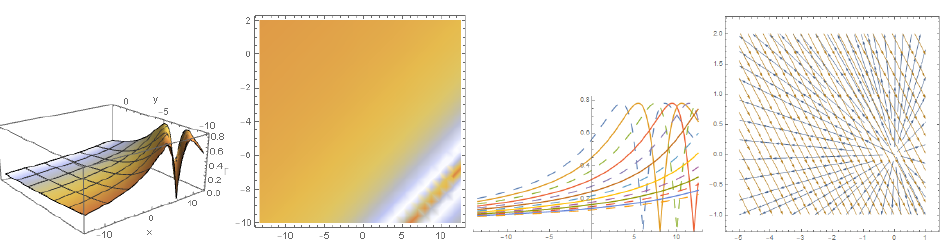
Figure 1. Evolution plots for Γ 1 ( x , y , t ) with the values η = − 1, c = 2, ρ = 2, λ = 2, m 4 = 9, and t = 11.